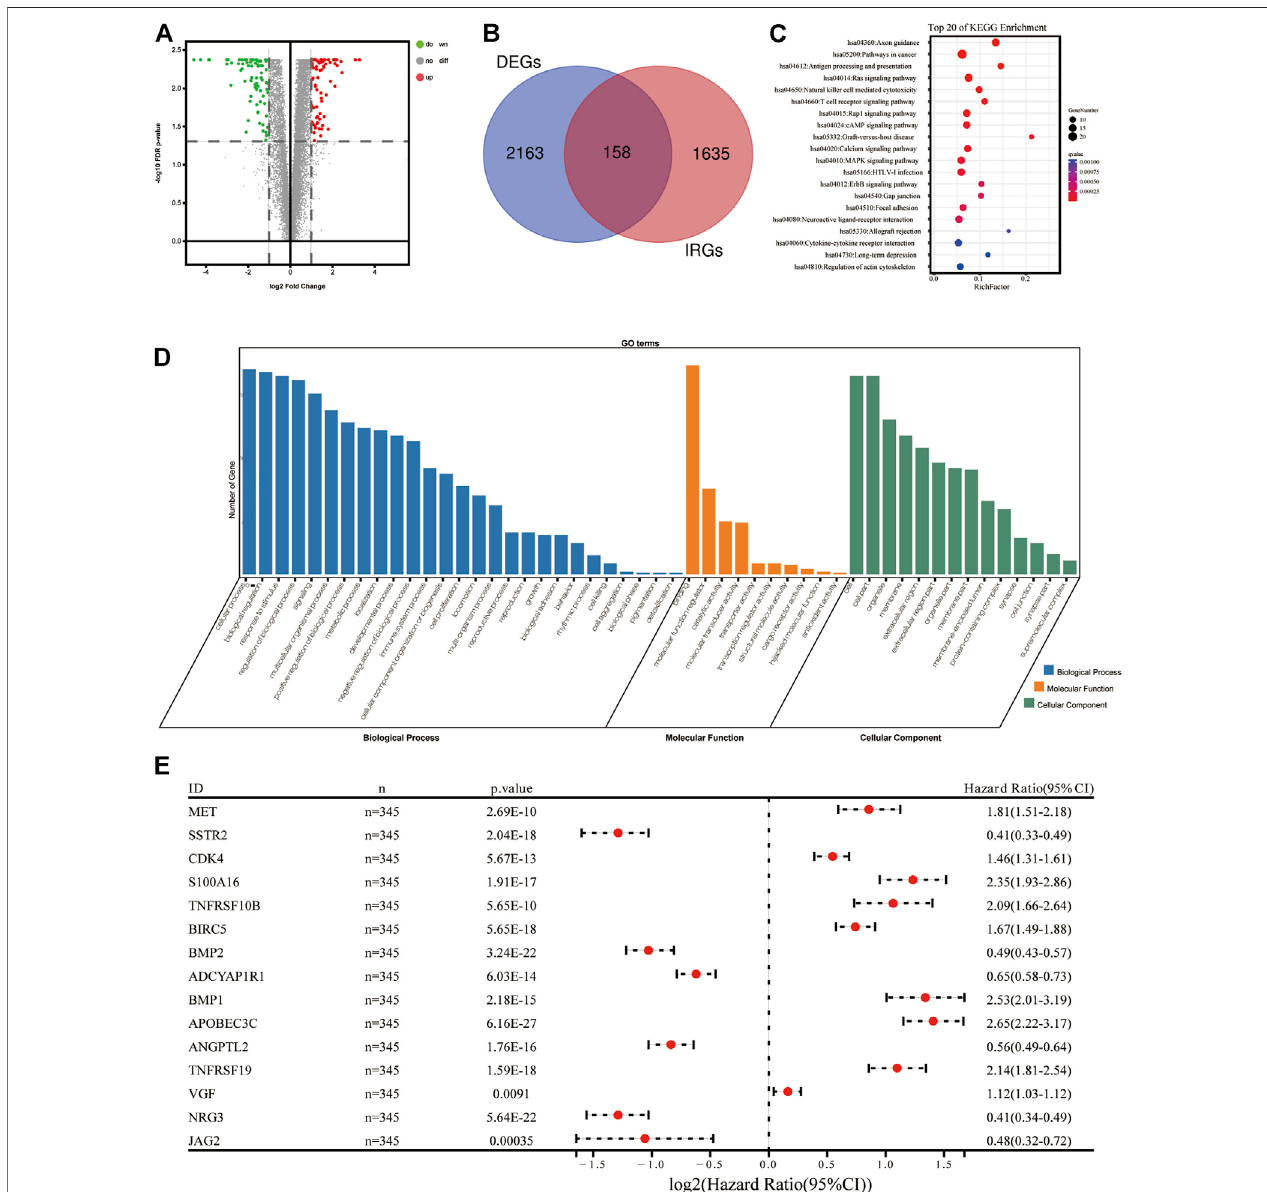
FIGURE 1 | Construction of immune-related signature for glioma. (A) Volcano diagram of DEIRGs between glioma and healthy brain tissues. (B) Venn diagram demonstrating the intersected genes between DEGs and IRGs. (C) Top 20 biological progresses of KEGG enrichment analysis of 118 DEIRGs. (D) GO enrichment analysis of 118 DEIRGs. Blue, orange and green columns indicated Biological Process, Molecular Function, and Cellular Component, respectively. (E) Forest diagram demonstrating the multivariable cox model results of 15 hub genes in the immune-related signature. DEIRGS, differentially expressed immune-related genes; DEGs, differently expressed genes; IRGs, immune-related genes; KEGG, Kyoto Encyclopedia of Genes and Genomes; GO, Gene Ontology.